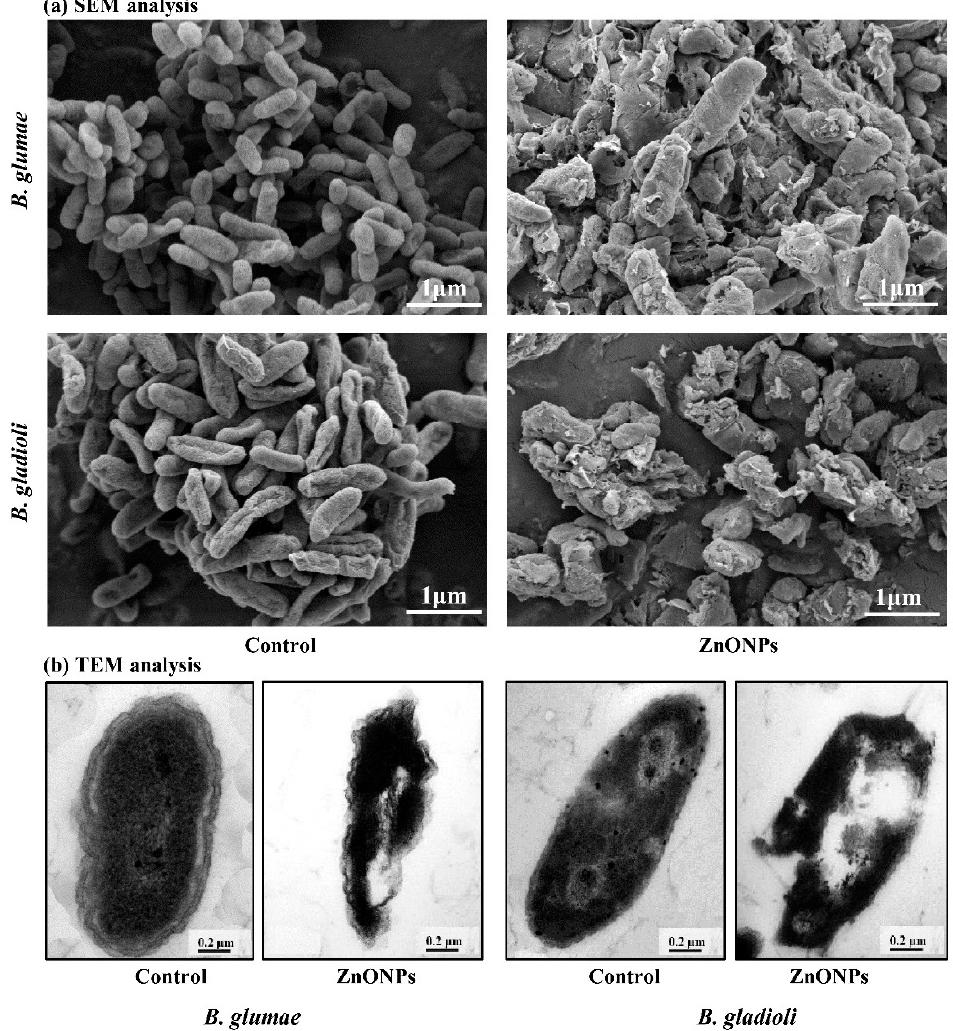
Figure 7. Electron microscopic SEM and TEM images of rice bacterial pathogens B. glumae and B. gladioli cells after 8 h treatment with (50 µg mL − 1 ) and without (control) biogenic ZnONPs. ( a ) SEM images reveal a highly ruptured structure and small cellular holes; ( b ) TEM images show integrated bacterial membranes, disorganized cytoplasm, and leakage of bacterial genetic material.